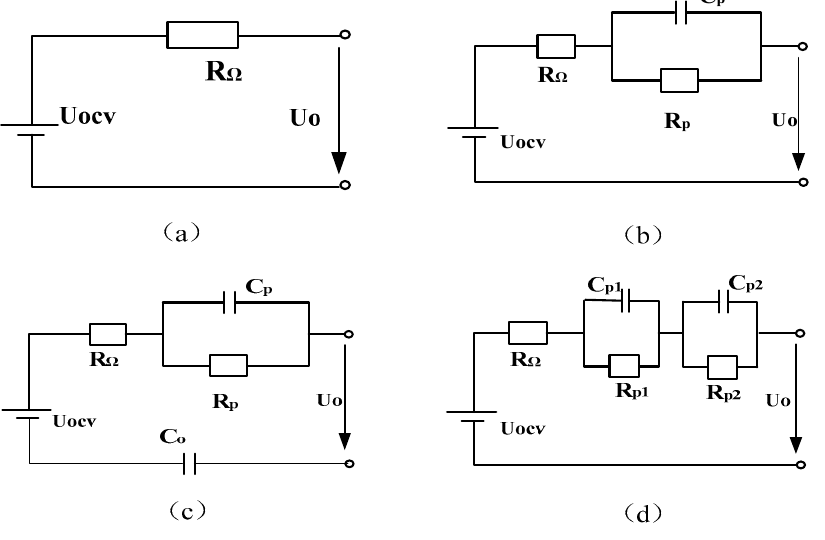
Figure 3. Schematic diagram of equivalent circuit mode: ( a ) The Rint model; ( b ) The Thevenin model; ( c ) The PNGV model; ( d ) The RC model.